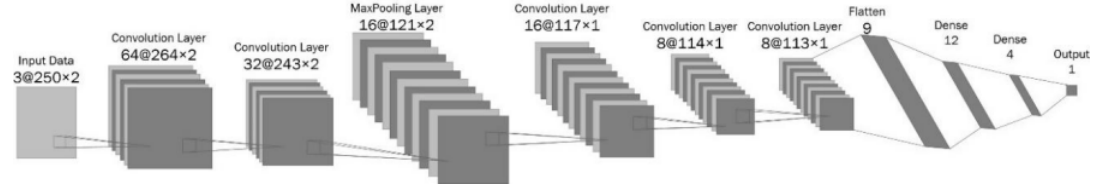
Figure 3. Neural network model.